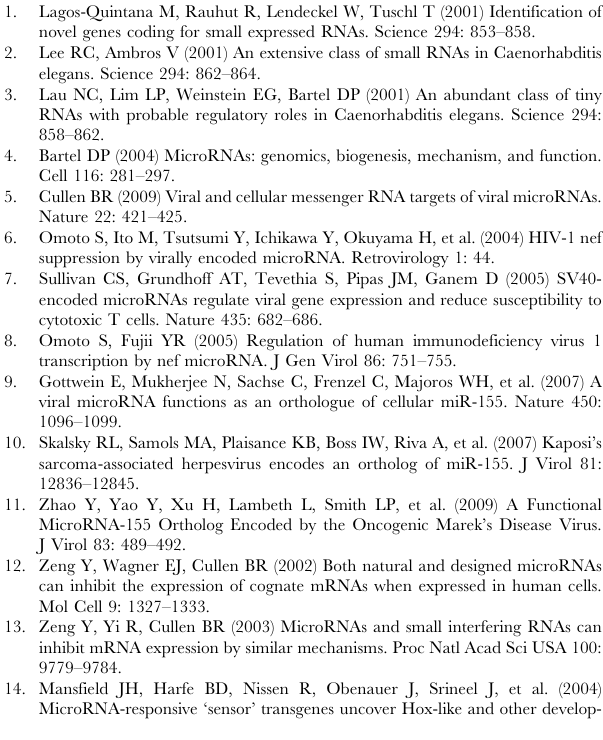
Table S1 Sequences of pre-miRNAs. * Artificial pre-